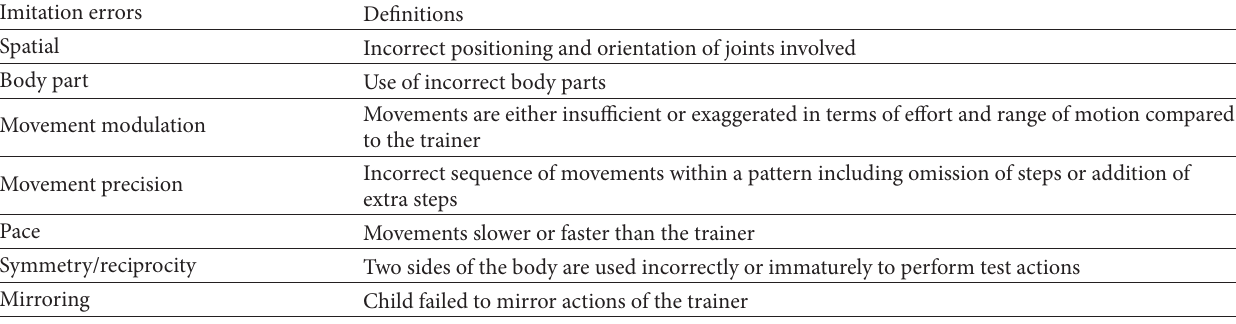
Table 3: Coding scheme to assess imitation/praxis errors.